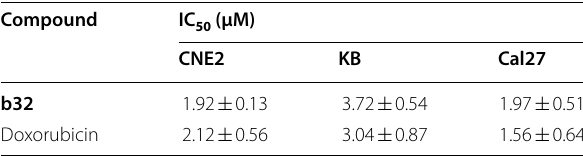
Table 28 In vitro anticancer activity of the synthesized compound